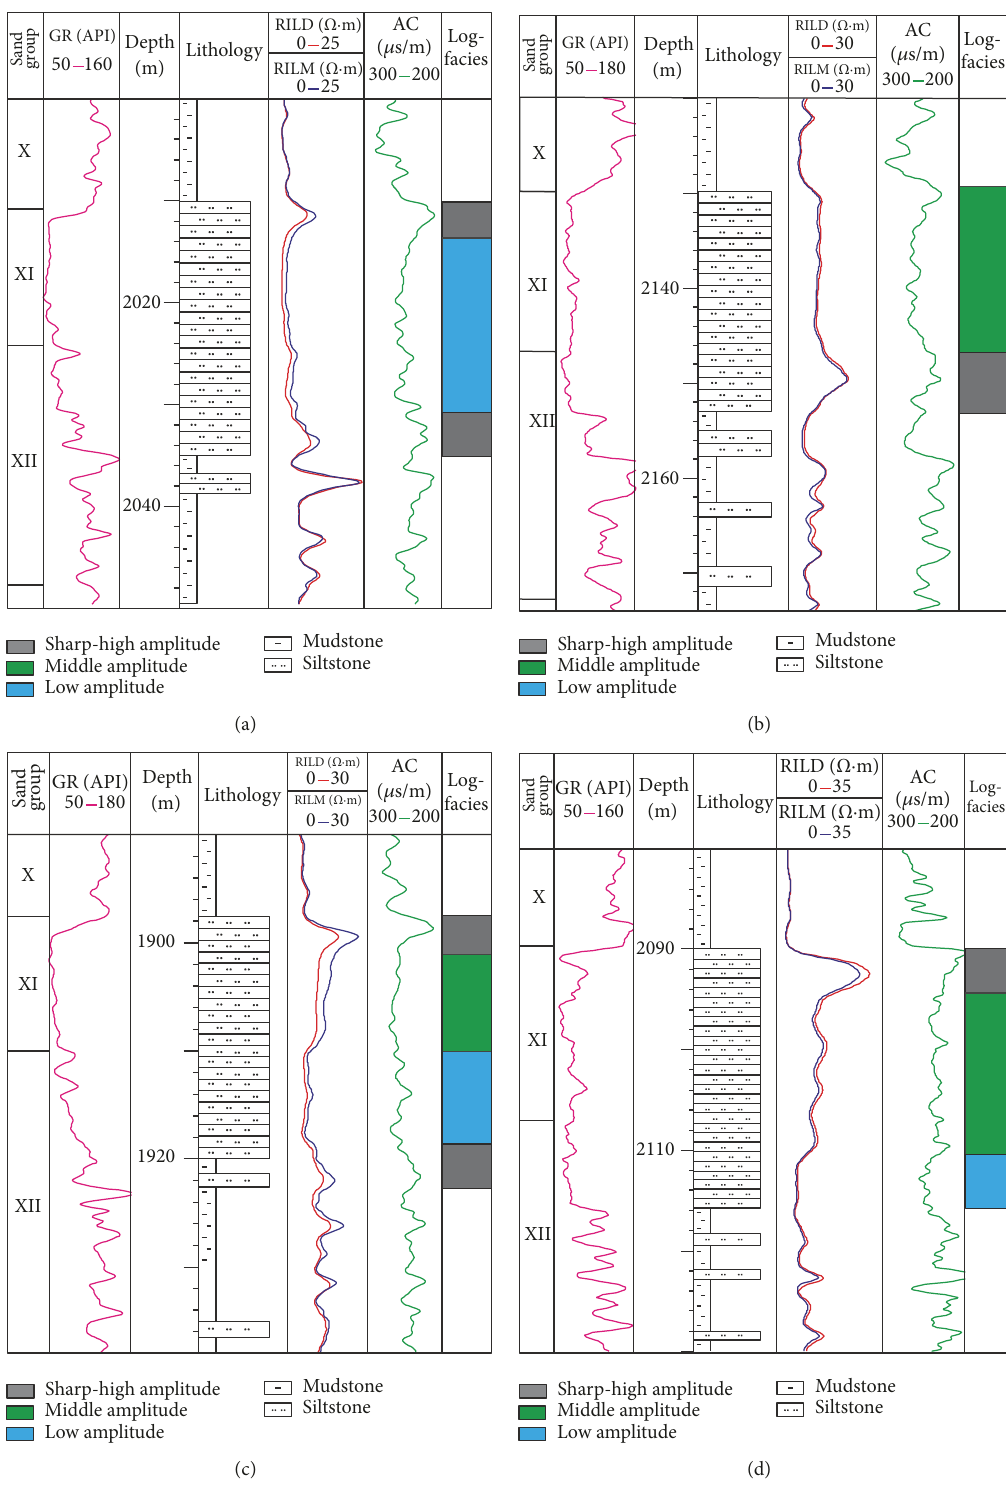
Figure 4: Petrophysical log response characteristics and logfacies of thick sand bodies in the Daqingzijing. (a) Integrated petrophysical and geological dataset of H15 well. (b) Integrated petrophysical and geological dataset of Qx 94-26 well. (c) Integrated petrophysical and geological dataset of H24 well. (d) Integrated petrophysical and geological dataset of Qx 110-36 well. GR means natural gamma ray logging, RILD means deep induction logging resistivity, RILM means medium induction logging resistivity, and AC means acoustic